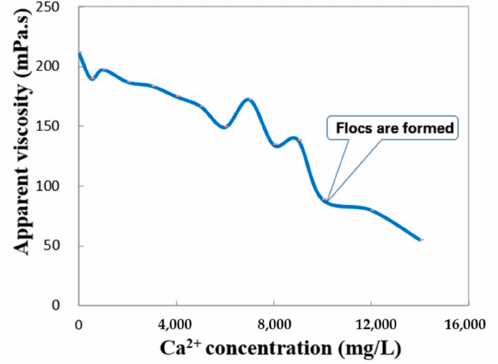
Figure 10. Ca 2+ concentration versus apparent viscosity.